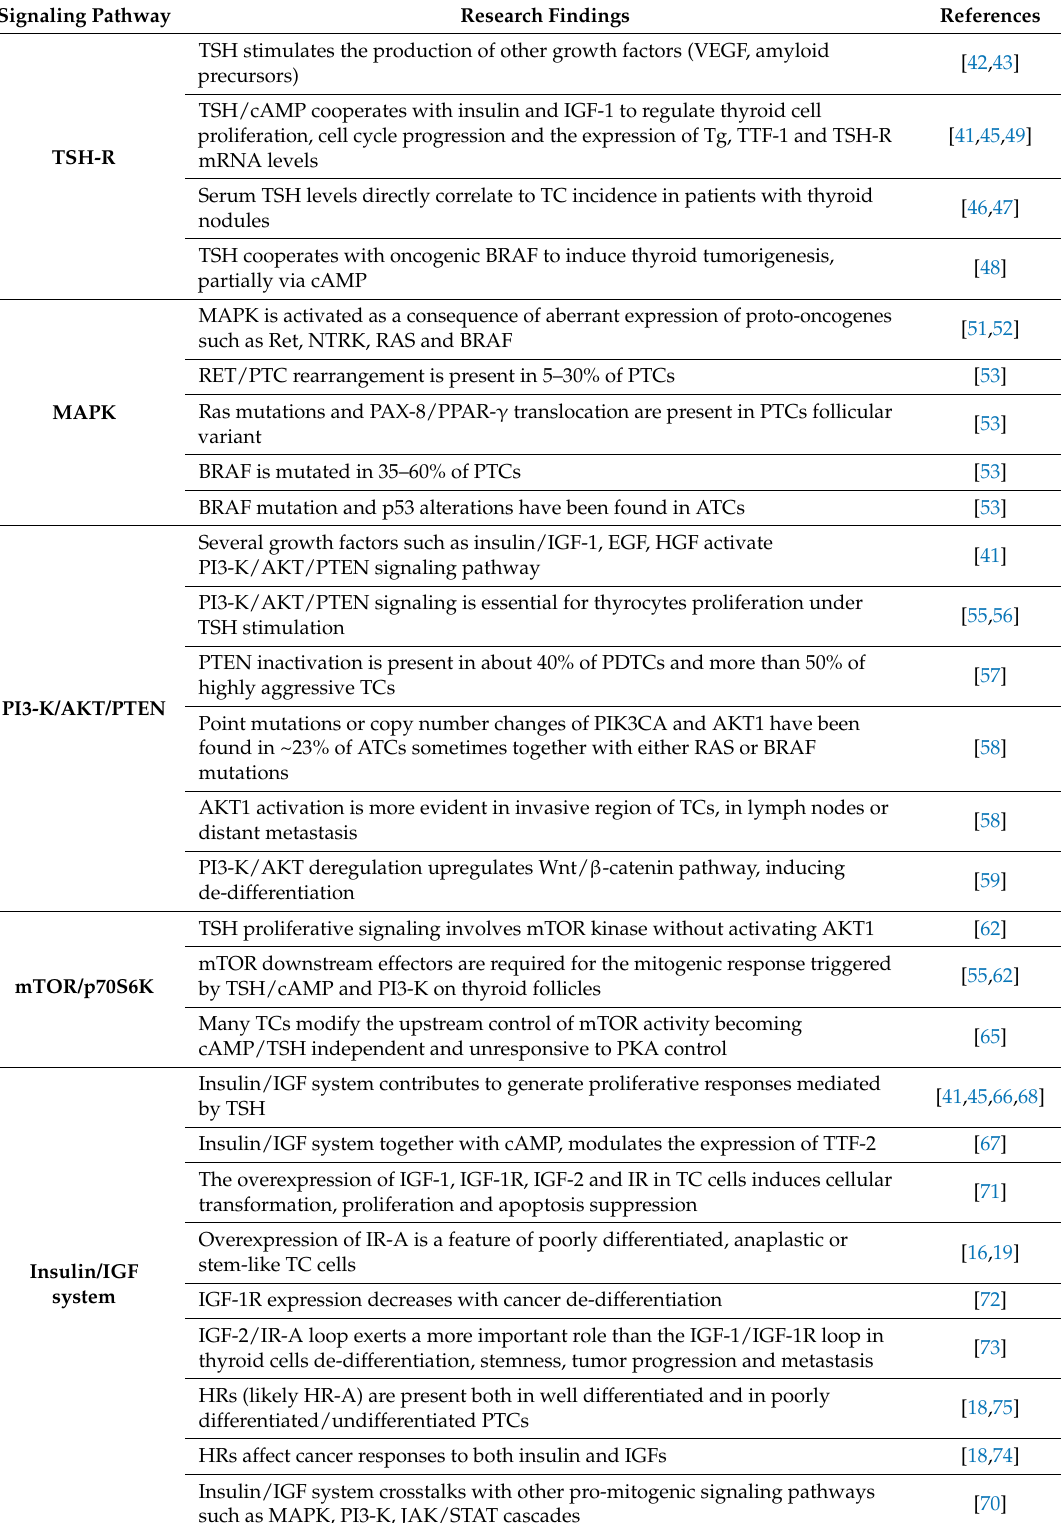
Table 1. Molecular abnormalities and deregulated signaling pathways involved in